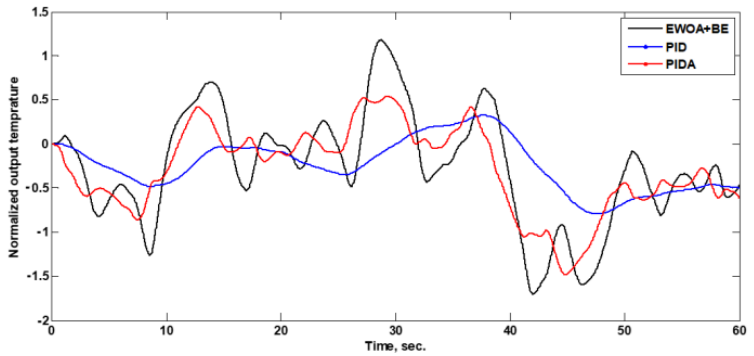
Figure 12. System dynamic response of the fourth scenario.